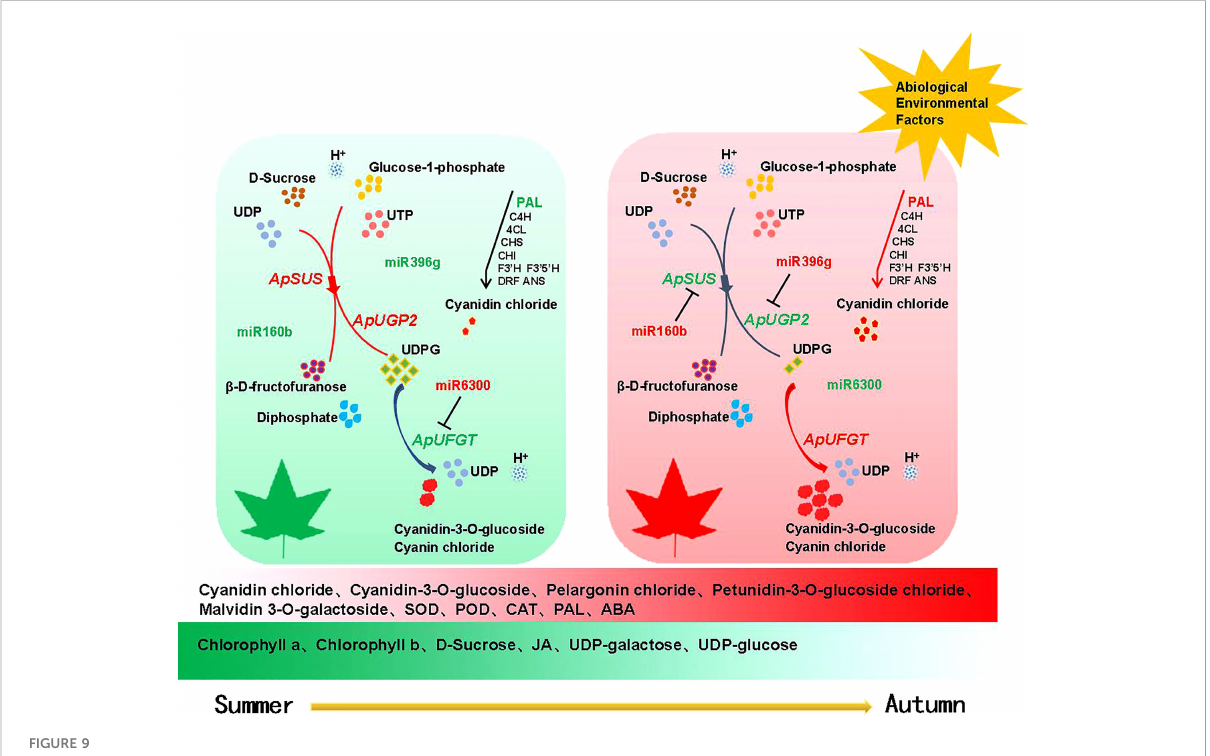
FIGURE 9 Regulation pattern of miRNAs and target genes during color transition in A. p. subsp. mono leaves. Note Red represents upregulated expression and green represents downregulated